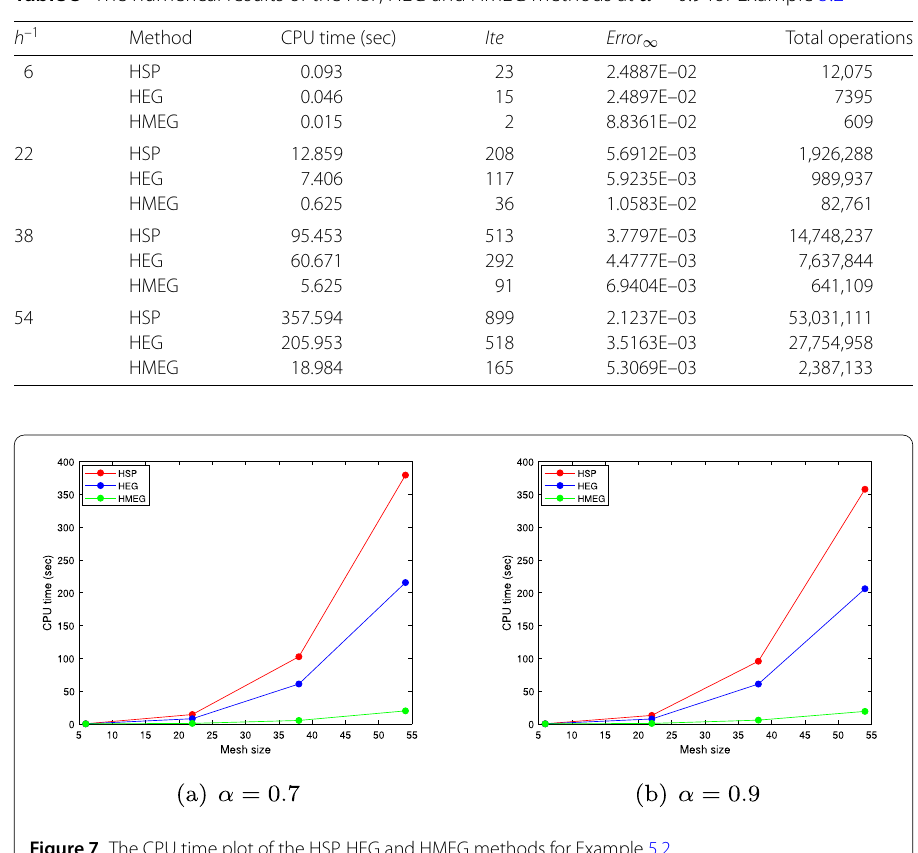
Figure 7 The CPU time plot of the HSP, HEG and HMEG methods for Example 5.2